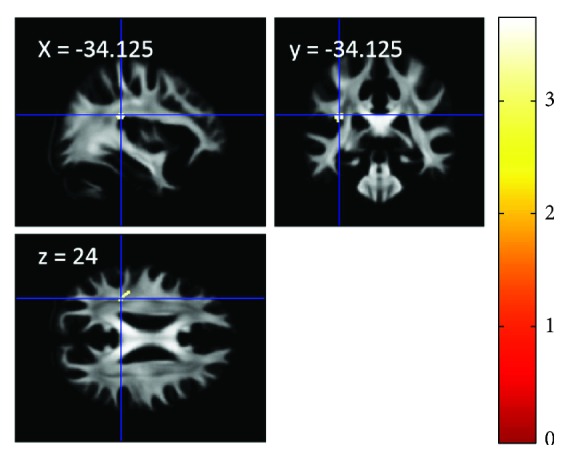
The effect of training with TCSSL on FA. The results are shown with P < 0.05, corrected for multiple comparisons at cluster-level within the area of the left AF with an underlying voxel-level of P < 0.001, uncorrected. There was a larger increase in FA in the training with TCSSL group compared with the active control group. Compared with the active control training, the training with TCSSL resulted in an increase in FA of an area in the left AF (this analysis was performed to identify differences in pre- to posttraining changes between groups, as described in the Methods section). Regions showing a significant effect were overlaid on mean preprocessed, but not smoothed, FA images of the participants.